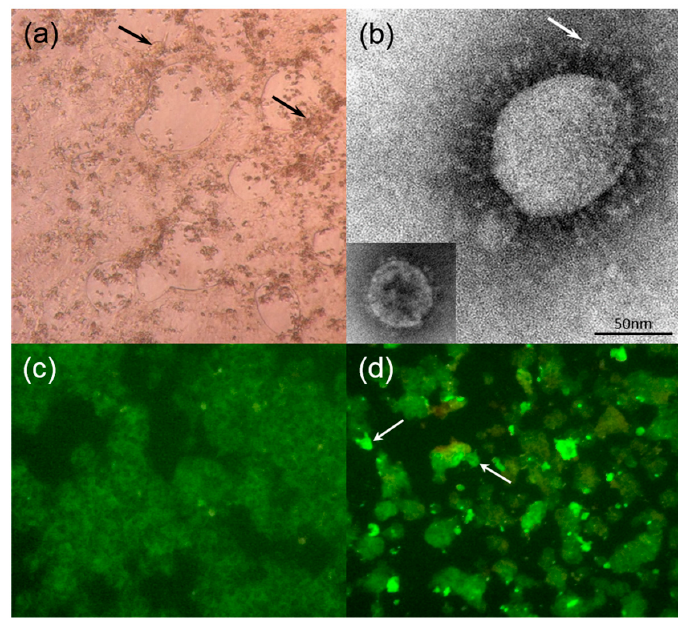
Figure 1. ( a ) HRT-18G cells infected with dromedary camel coronavirus (DcCoV) UAE-HKU23 showing cytopathic effects with rounded, aggregated, fused, and granulated giant cells rapidly detaching from the monolayer at day 5 after incubation (arrows) (original magnification 40×); ( b ) Negative contrast electron microscopy of ultracentrifuged deposit of HRT-18G cell culture-grown DcCoV UAE-HKU23, showing typical club-shaped surface projections (arrow) of coronavirus particles, with rabbit coronavirus HKU14 as the control (bottom left corner). Bar = 50 nm; Indirect immunofluorescent antigen detection in ( c ) uninfected and ( d ) infected HRT-18G cells using serum from dromedary showing apple green fluorescence in (arrows) DcCoV UAE-HKU23 infected HRT-18G cells (original magnification 100× for both).